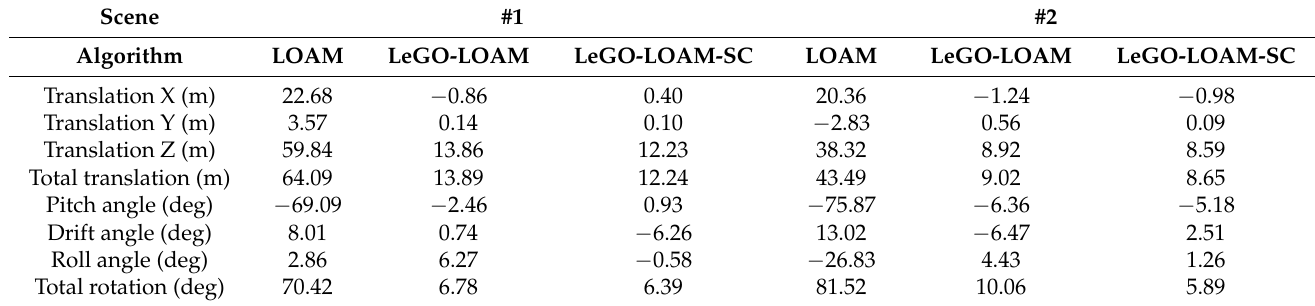
Table 3. The estimation error when returning to the starting position.